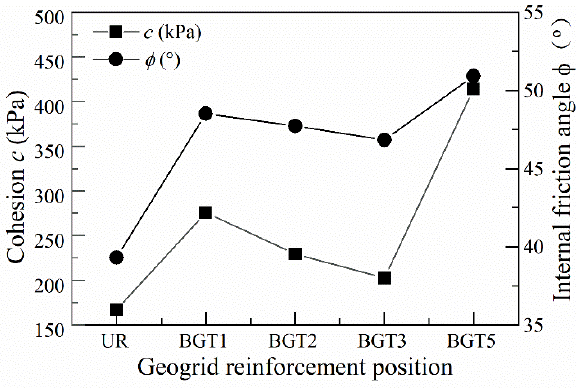
Figure 10. Effect of geogrid reinforcement position on shear strength.